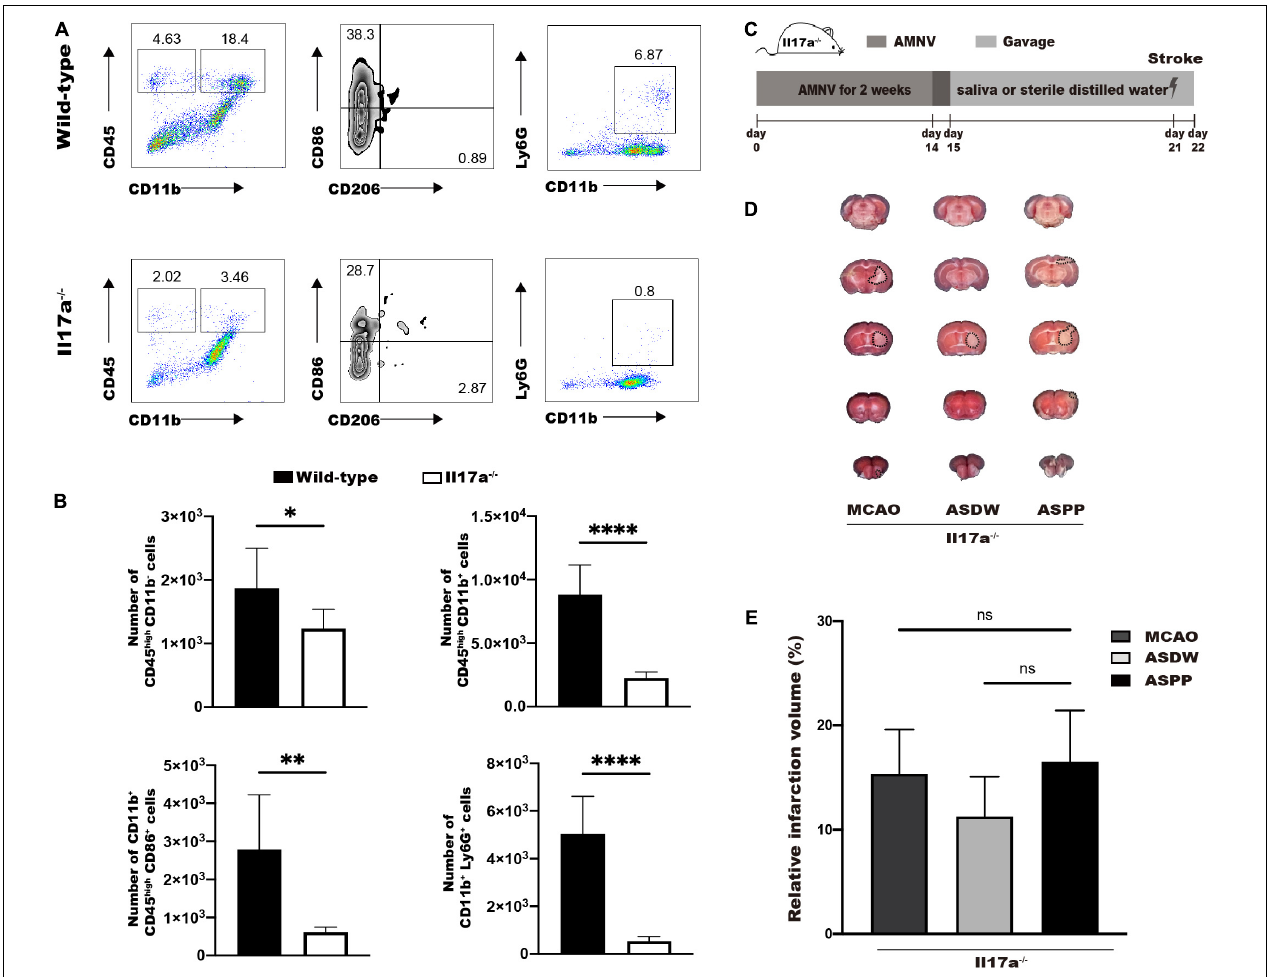
FIGURE 6 | IL-17A is indispensable for the aggravation of ischemic stroke induced by gavage of periodontitis salivary microbiota. (A) Representative flow cytometry analysis of immune cells in ischemic brain of wild-type and Il17a − / − mice after MCAO. (B) Quantifications of immune cells in (A) . n = 6:6:6:6. (C) Experimental design for testing the role of IL-17A in salivary microbiota-induced aggravation of ischemic stroke. (D) Representative TTC-stained image in Il17a − / − mice 1 day after MCAO. (E) Quantification of infarct volume. n = 5:5:5. Values represent the mean ± SD . Student’s t -test was used for statistical analysis in (B) , and One-Way ANOVA was used in (E) . ns, not significant; ∗ p < 0.05, ∗∗ p < 0.01, ∗∗∗∗ p <